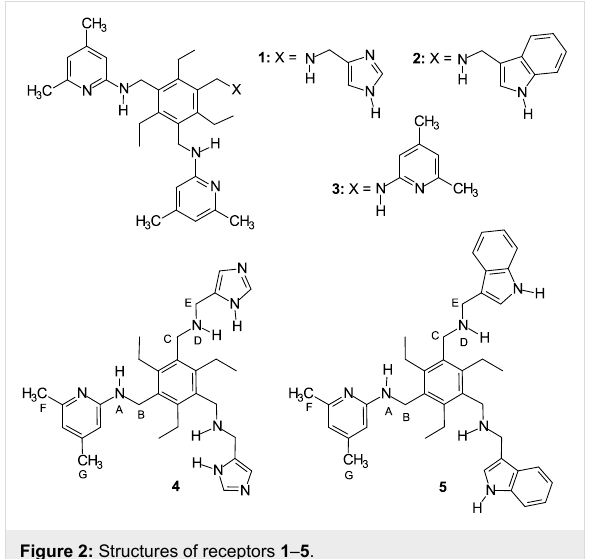
Figure 2: Structures of receptors 1 – 5 .